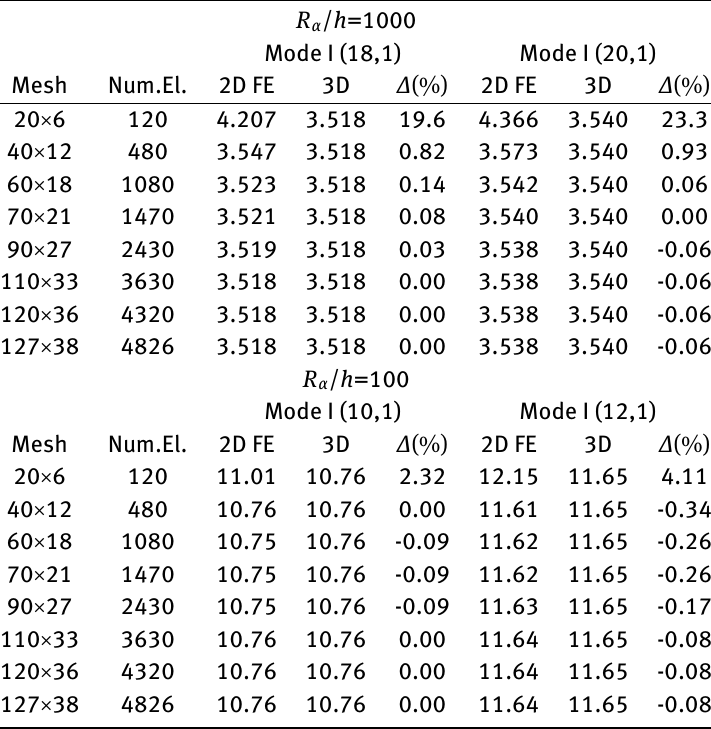
Table 6: Second assessment for the 2D FE solution, simply supported cylinder made of aluminium alloy and titanium alloy with thickness ratios R α / h =1000 and R α / h =100. First two frequencies in Hz, comparison between the present 3D exact solution and the 2D FE solution via Nastran. The error is calculated as ∆ (%) = FE −3 D × 100 3 D